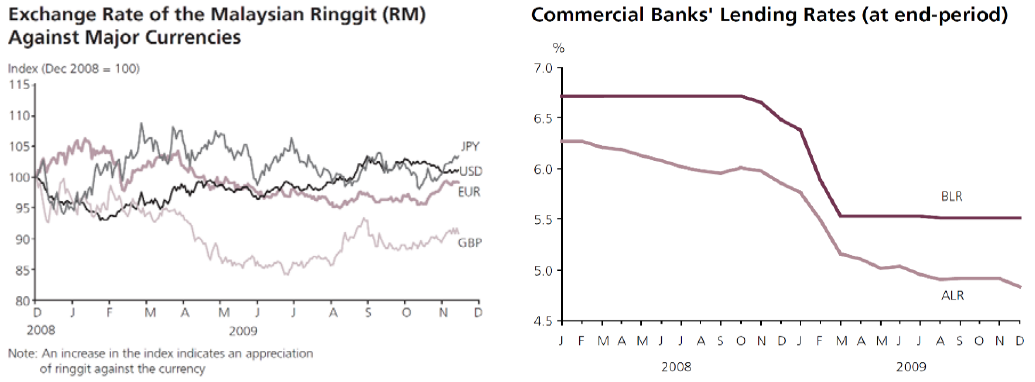
Figure 1. Comparison of exchange rate. Source: Bank Negara Malaysia (2009).